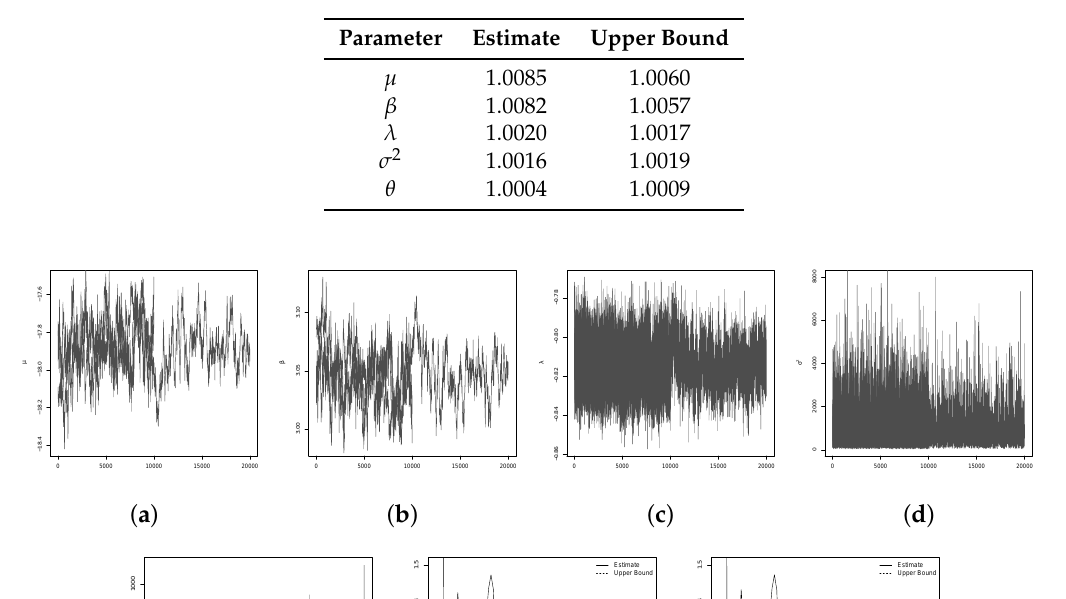
Table 3. Gelman and Rubin’s criterion to verify the parameters convergence of the hierarchical TLL distribution.